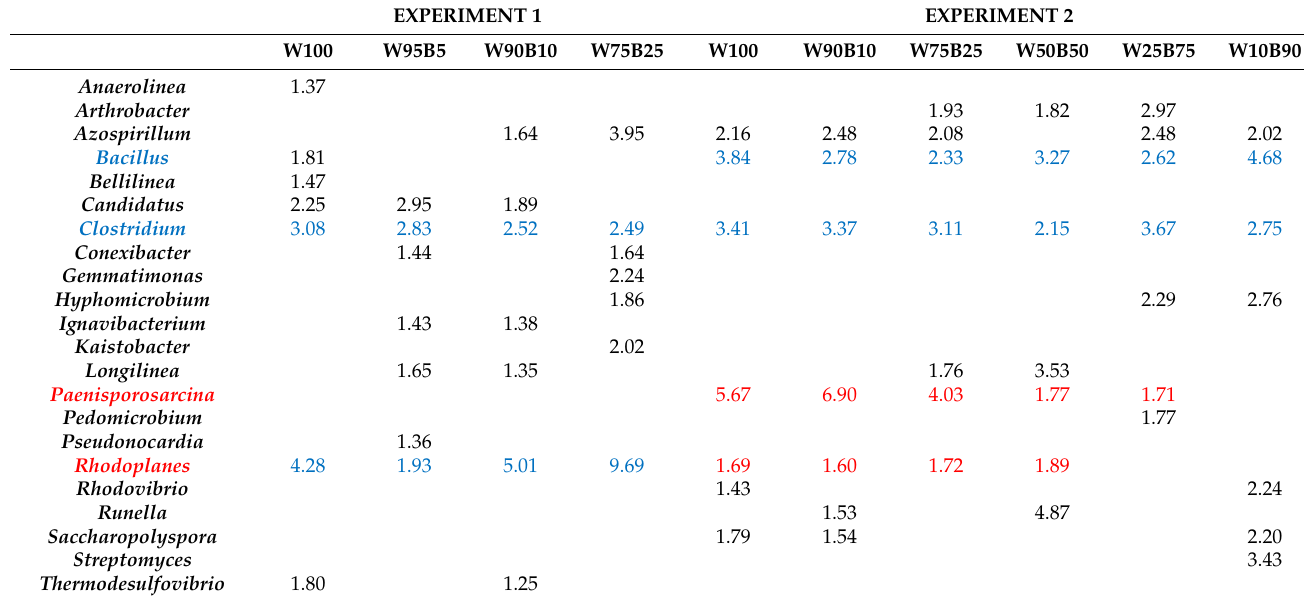
Table 4. Genus classification for worm castings (W) blended with biochar (B) by percent of total nucleic acids in the sample metagenome.